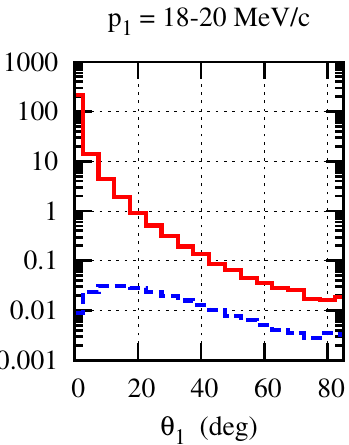
Figure 4. Angular distributions of e + (red line) and (cid:2) + of the mass 9 MeV (blue line) in the Bether- Heitler model. Strong excess of e + at very small angles becomes less prominent at angles of order 40